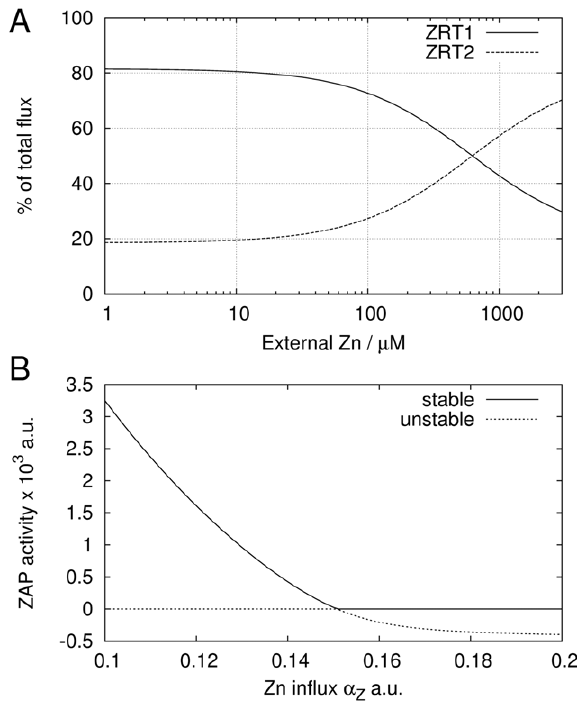
Figure 3. Yeast: Role of ZRT1 and ZRT2 and ZAP1 feedback. A, contributions of ZRT1 or ZRT2 to the total zinc influx for varying external zinc concentration. B, ZAP1 activity for varying values of ZRT independent influx a Z . The stable solution is marked with a solid line, the unstable solution is dotted.